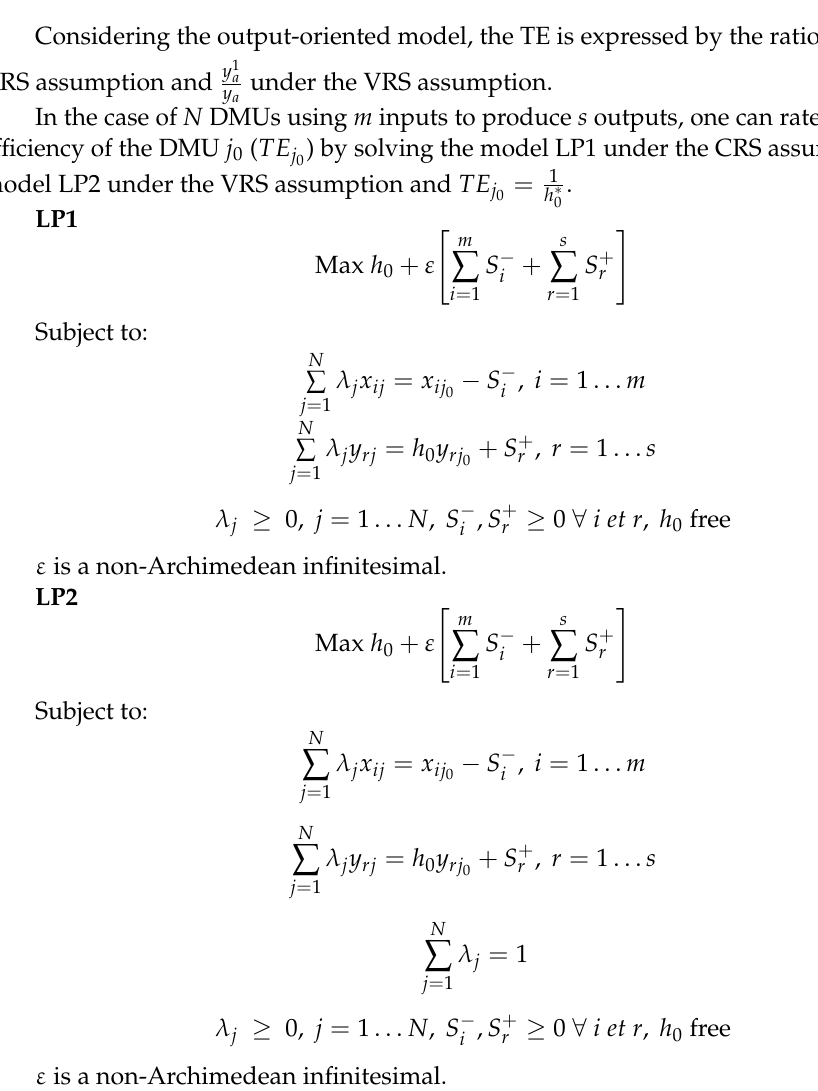
Figure 3. Production frontier and technical efficiency measurement.